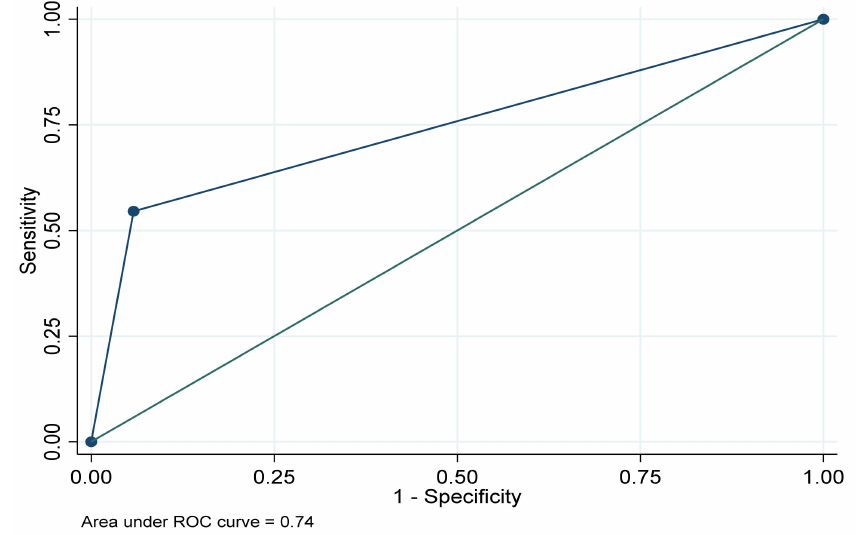
Figure 1. Area under the receiver operating characteristic curve (ROC) for the SRD indicator using the PHQ-8 as reference. European Health Interview Survey in Spain, 2014 /